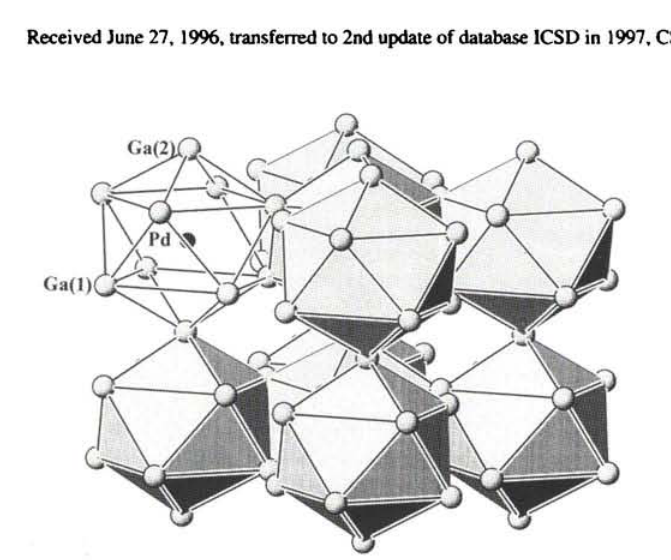
Table 1. Parameters used for the X-ray data collection